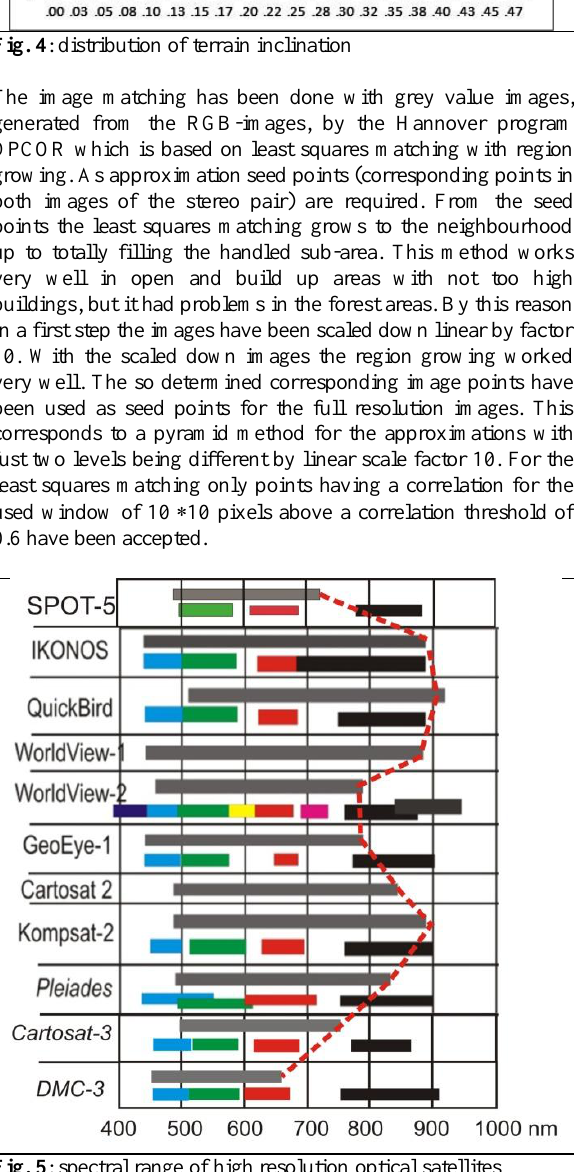
Fig. 5 : spectral range of high resolution optical